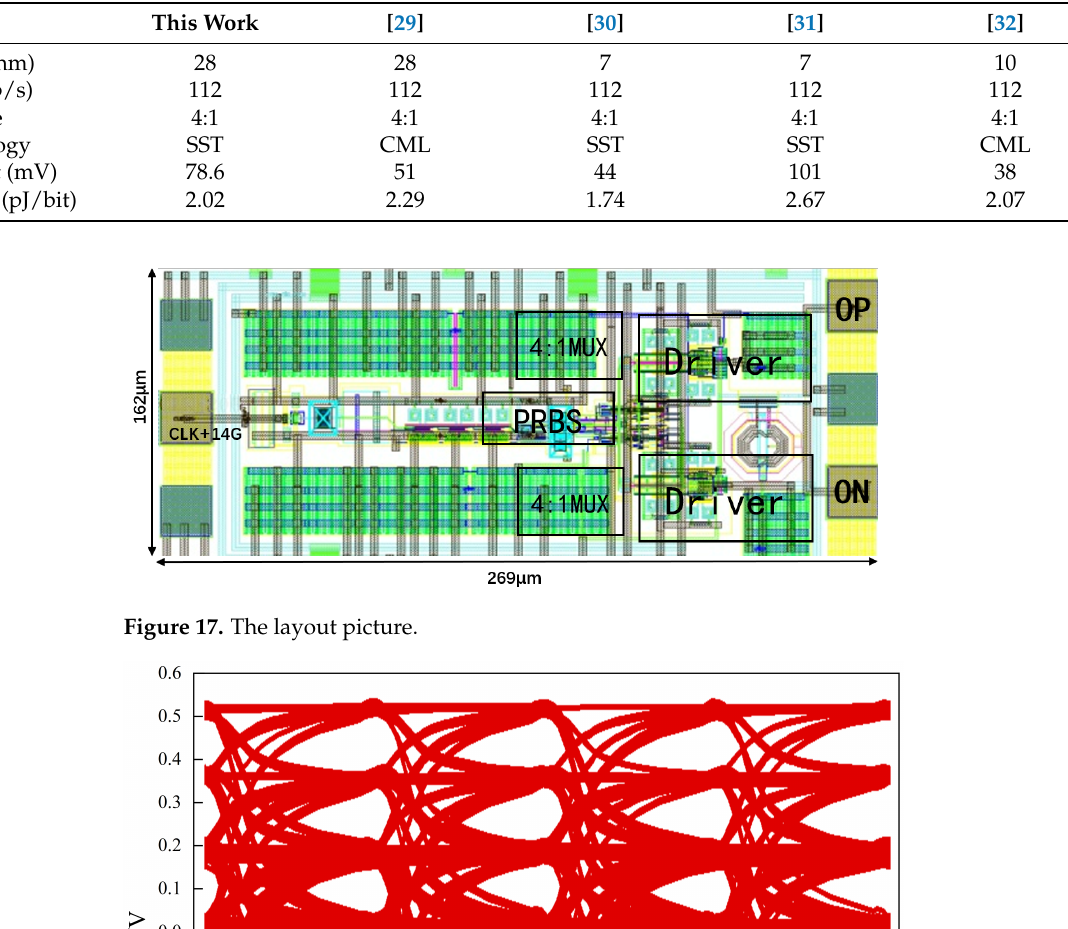
Table 1. Performance summary and comparison.